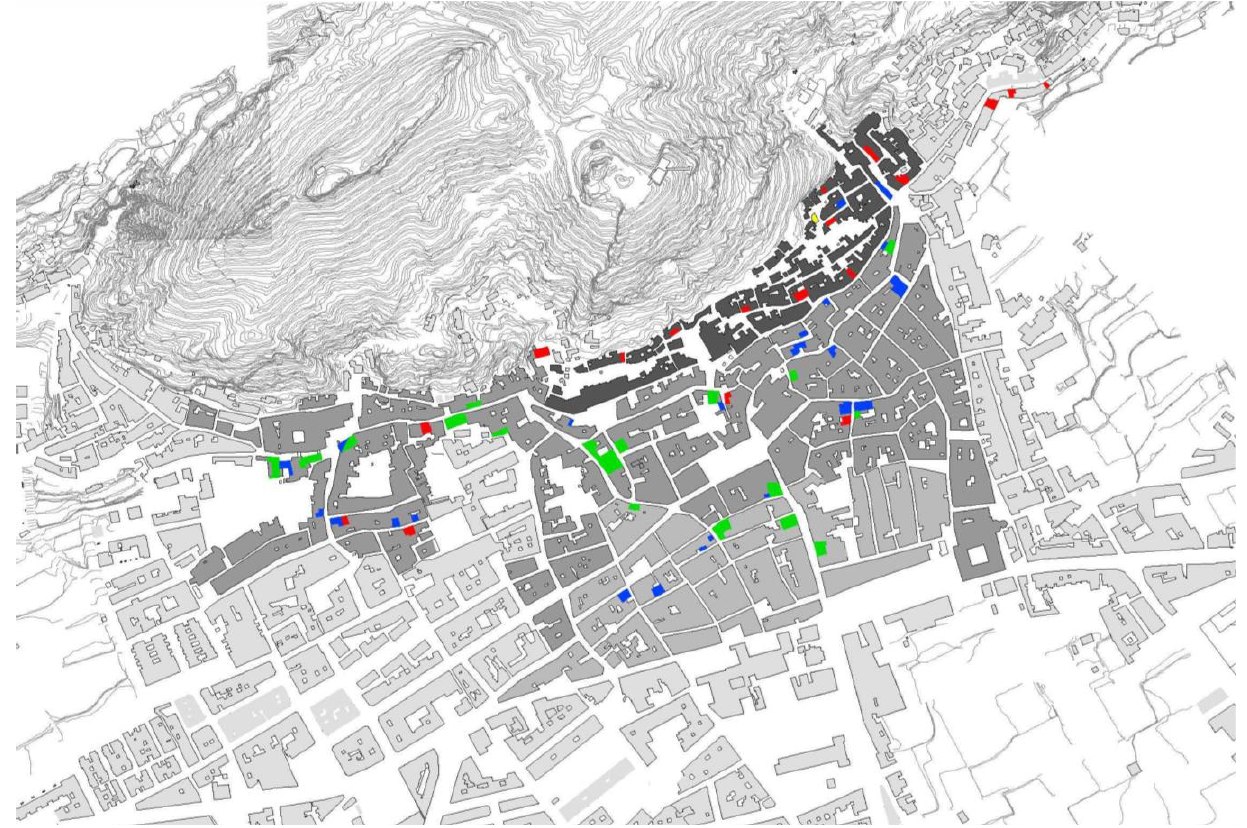
Figure 6. Plan showing the buildings included in the study (Red: simple rammed earth; Blue: Supplemented rammed earth; Green: mixed rammed earth and Yellow: dug-out) (Source: authors).